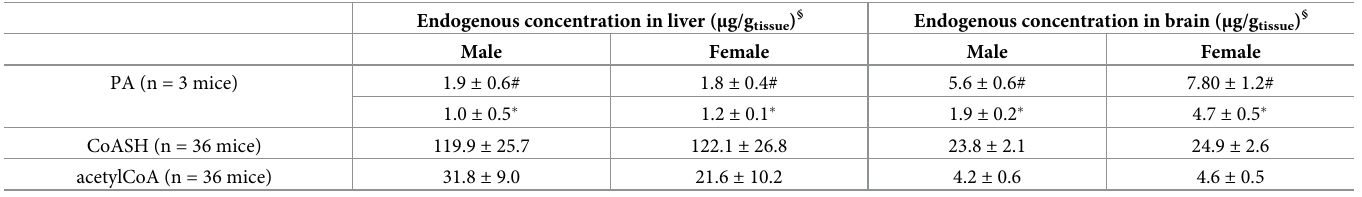
Table 3. Average endogenous level of pantothenic acid (PA), free CoA (CoASH) and acetylCoA in the male and female C57BL/6N mouse liver and